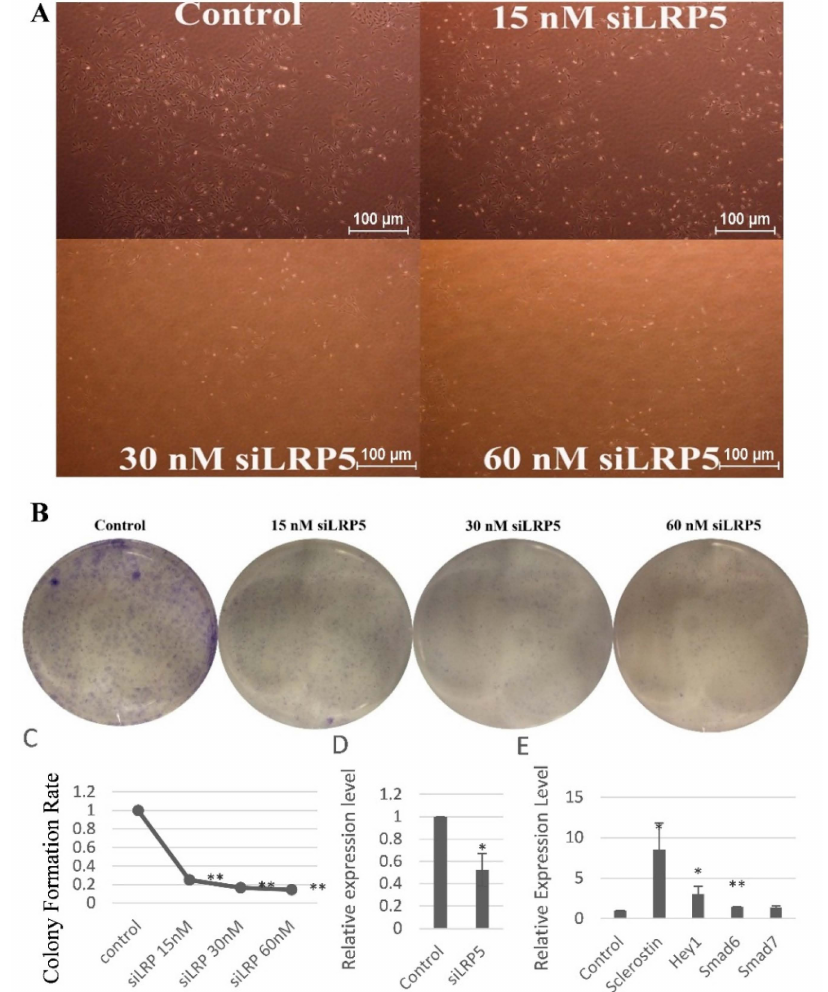
Figure 6. LRP5 played positive roles in the skeletal development. ( A ) Representative photos of MC3T3-E1 cells transfected with siLRP5; ( B ) Representative pictures of colonies of MC3T3-E1 cells transfected with siLRP5; ( C ) The clonogenic potential of MC3T3-E1 cells transfected with siLRP5; ( D ) Expression levels of RUNX2 in MC3T3-E1 cells upon siLRP5 treatment; ( E ) Fold changes of sclerostin, Hey1, Smad6, and Smad7 in MC3T3-E1 cells upon siLRP5 treatment. * p < 0.05, ** p < 0.01. n =